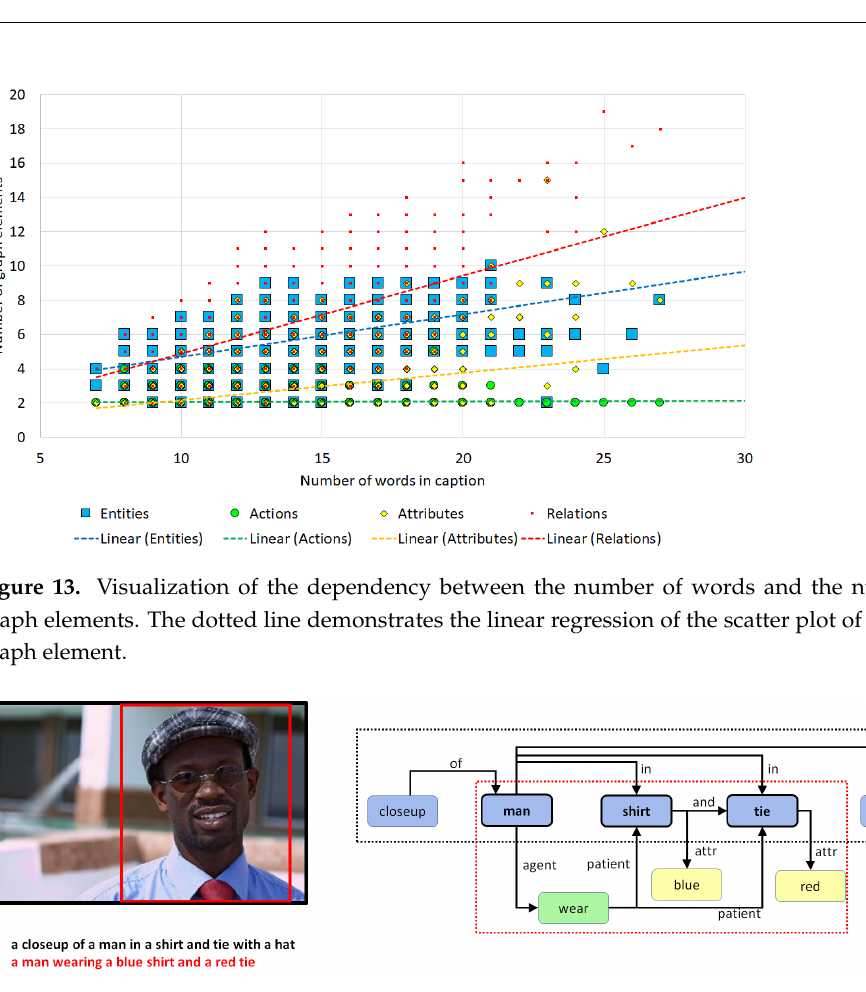
Figure 14. Holistic scene graph from a simple image with a single object of interest.